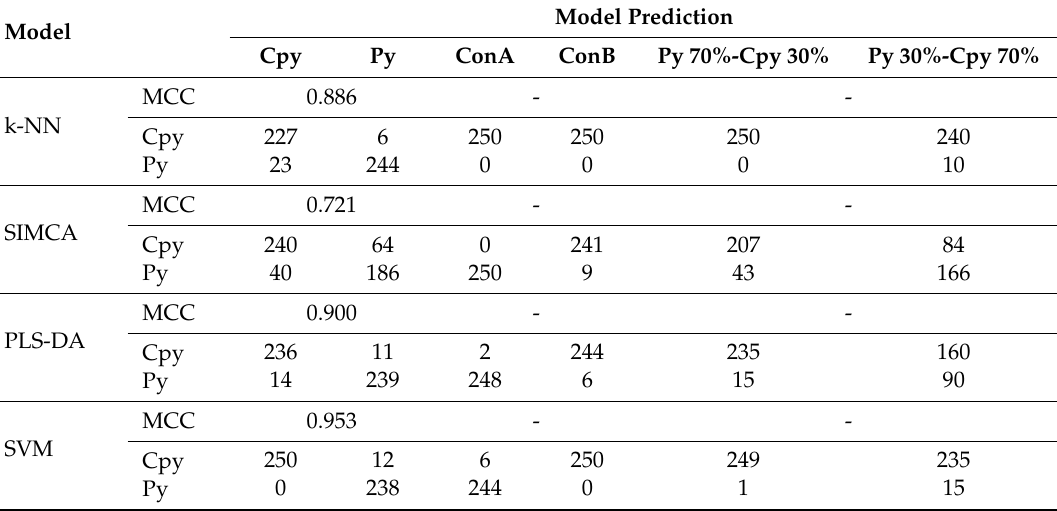
Table 6. Prediction of chalcopyrite, pyrite, concentrates, and sulfide mixture by the trained